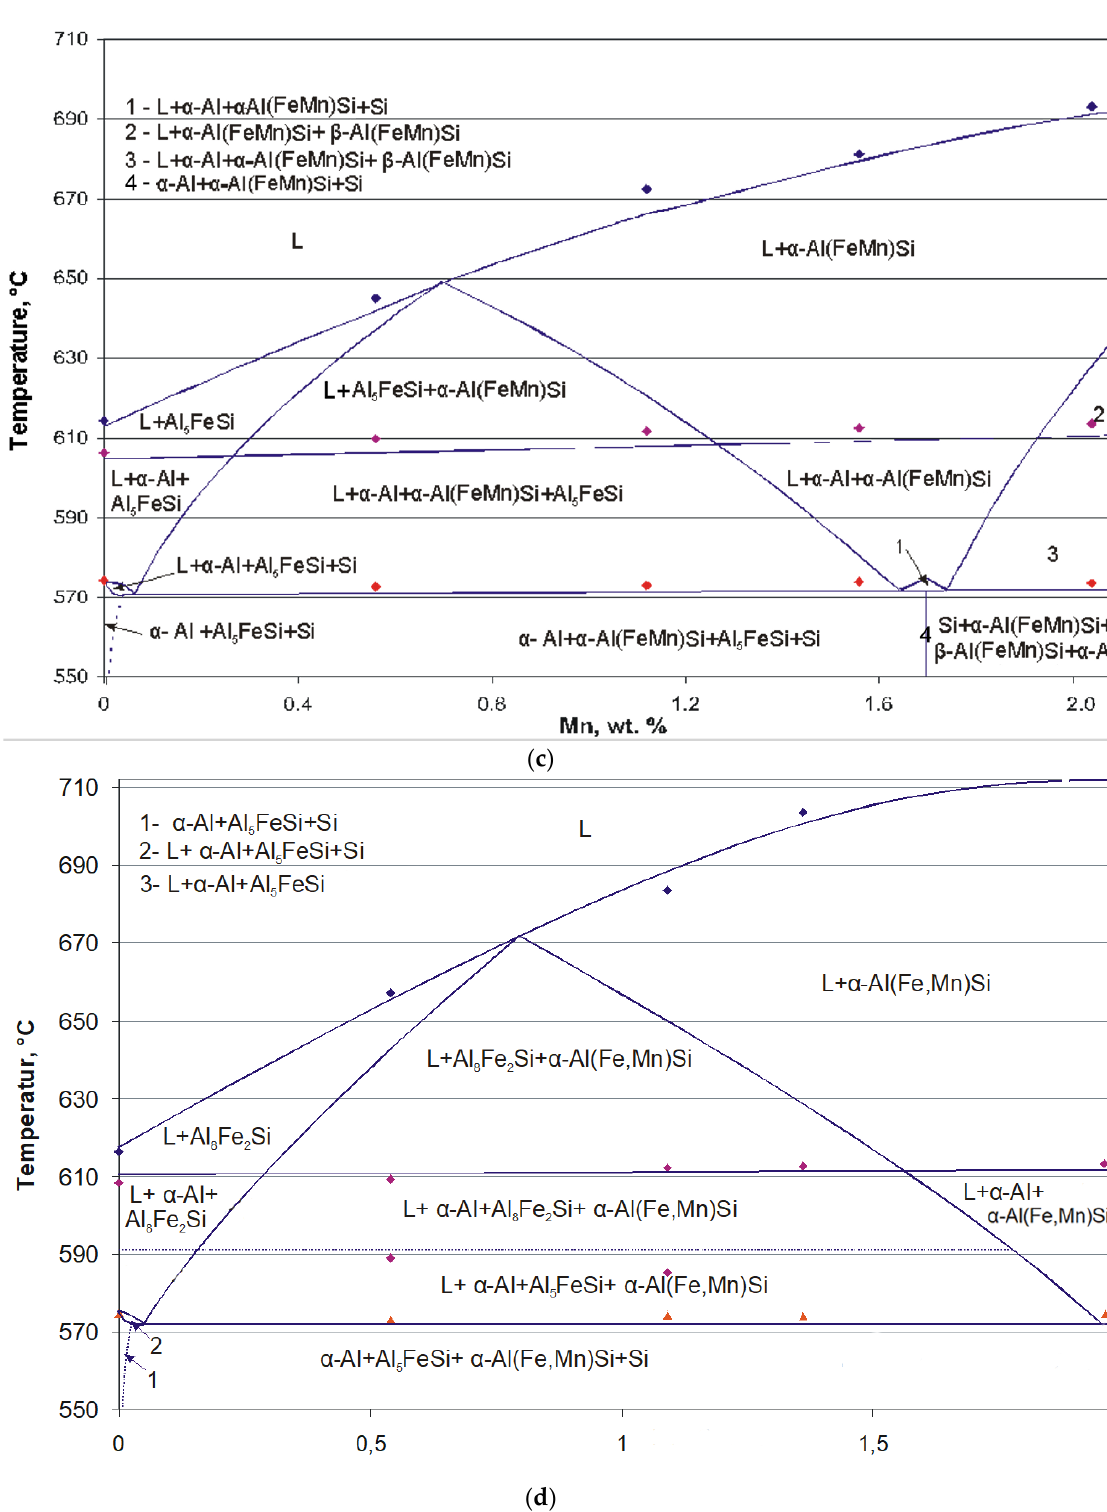
Figure 8. ( a ) Isopleth AlSi8Fe0.5–Mn. At 0, 0.5, 1, 1.5, and 2.0 wt. % Mn concentrations, three points were set vertically, according to the DTA results shown in Table 4. ( b ) Isopleth AlSi8Fe1–Mn. At 0, 0.5, 1, 1.5, and 2.0 wt. % Mn concentrations, three points were set vertically according to the DTA results shown in Table 4. ( c ) Isopleth AlSi8Fe1.5–Mn. At 0, 0.5, 1, 1.5, and 2.0 wt. % Mn concentrations, three points were set vertically according to the DTA results shown in Table 4. ( d ) Isopleth AlSi8Fe2–Mn. At 0, 0.5, 1, 1.5, and 2.0 wt. % Mn concentrations, four points were set vertically according to the DTA results shown in Table 4.